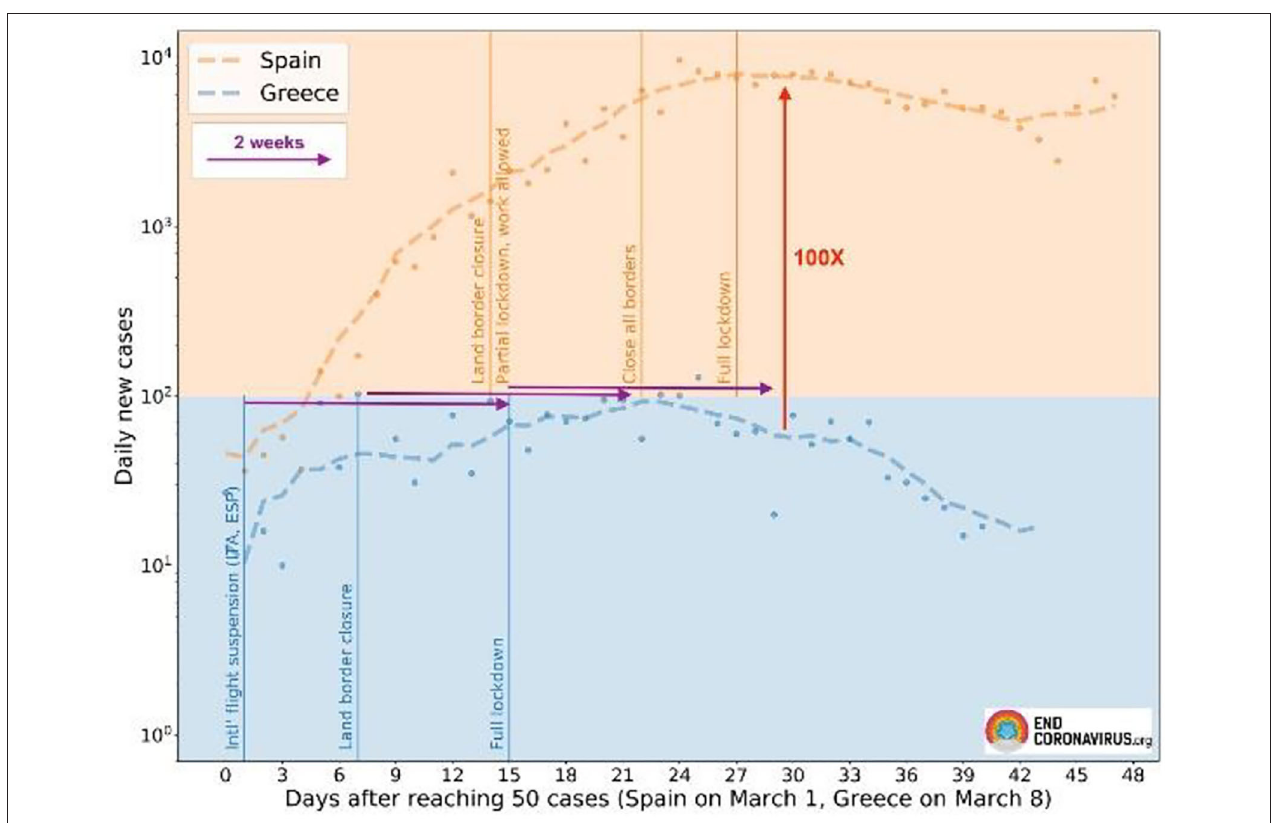
FIGURE 2 | Escalation of Measures: Spain v. Greece (Source: Yaneer Bar-Yam, EndCoronavirus.org).